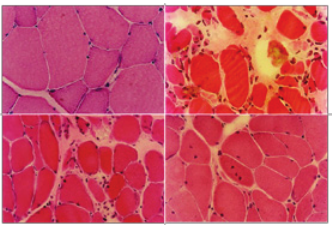
FIGURE 5 – Photomicrographs of the cranial tibial muscle (hematoxylin-eosin, original magnification 540x). (Left, Above) Cranial tibial muscle histology in Gn (normal control group) showed large and polygonal muscle fibers, with peripheral nuclei and little conjuctive tissue, characteristic of normal muscle tissue. (Right, Above) Gd (denervation control group). There was well defined muscular atrophy, with a predominance of considerably reduced diameter fiber groups, with few cells presenting normal diameter and an abundance of conjunctive tissue, compatible with denervated muscle. (Left, Below) G1 (one-stage) and (Right, Below) G2 (two-stage) showed few polygonal cells in the midst of muscle fiber groups with considerably reduced area, which contrasted with others with considerably increased area and rounded shape. Some muscle fibers presented a centralized nucleus. Some regions had increased conjunctive tissue.